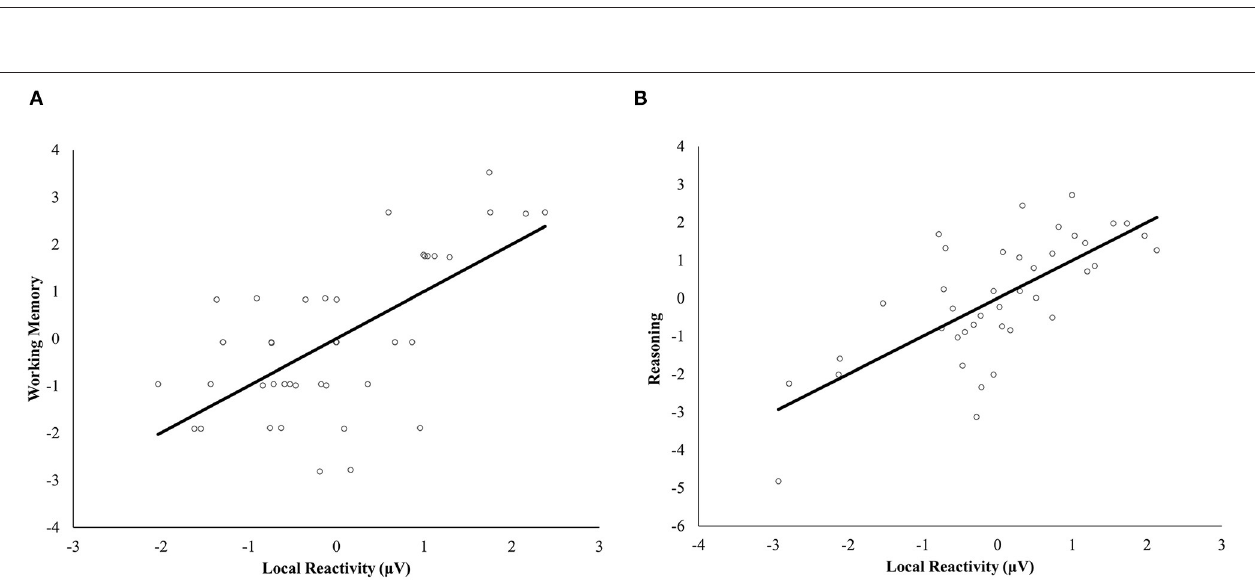
FIGURE 4 | Multiple regression scatterplots between local cortical reactivity after PFC stimulation and working memory (A) and reasoning (B) after controlling for targeting method, NfL levels, age, biological sex, and years of education. Z-scores were used on the Y-axis and unstandardized Predicted Values on the X-axis ( µ V).